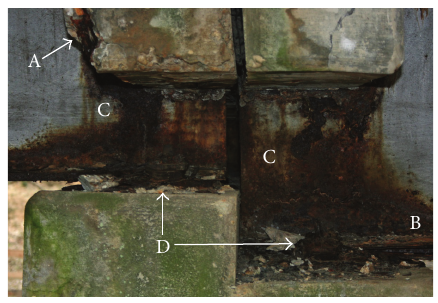
Figure 2: Example of a structurally deficient deck joint.